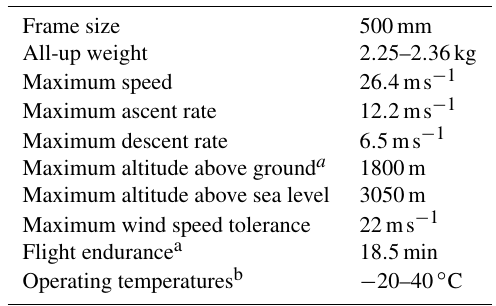
ternal hazards. The CopterSonde technical and performance specifications are summarized in Table 1.